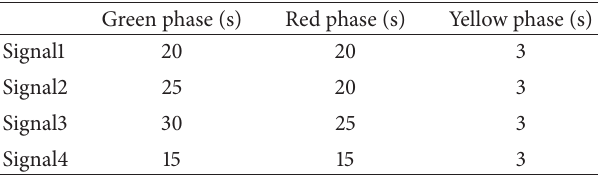
Table 2: Fixed signal times of the four signals in the